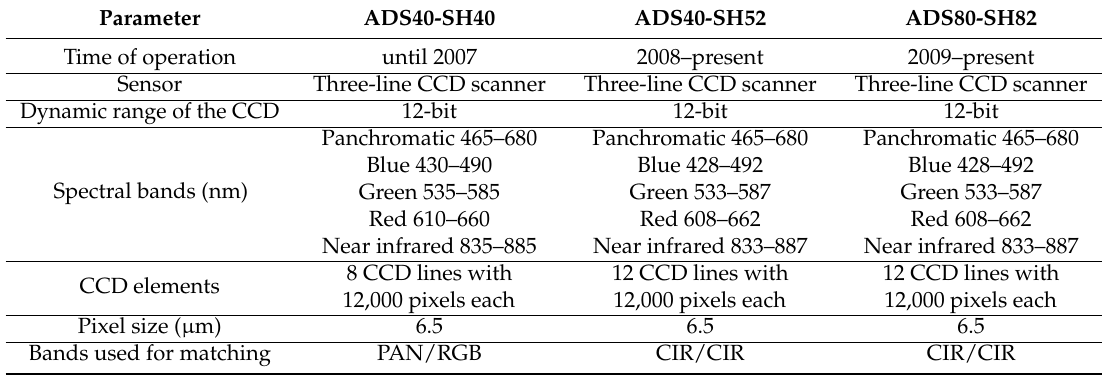
Table 1. Technical specifications of the ADS